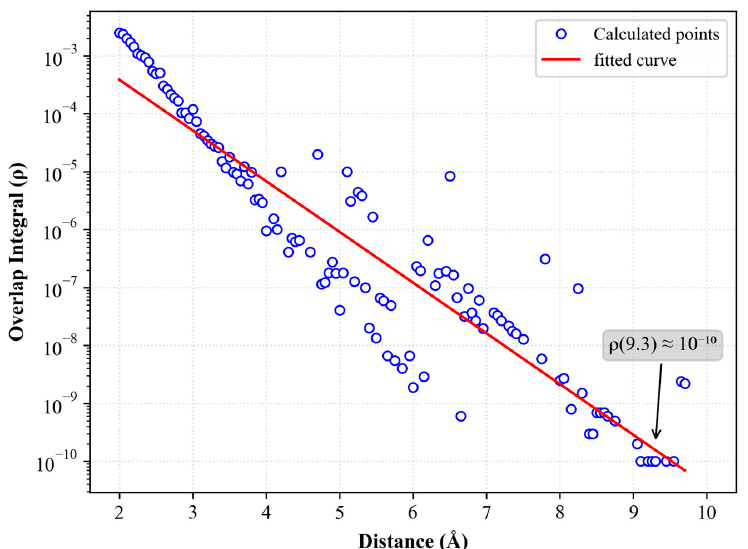
Figure 4. Calculated values and the linear fit of the overlap integral ( ρ ) between the valence orbitals of Cr(III) and Eu(III) ions as a function of the distance between the metal ions, R d − f , obtained with the procedure described in reference [51]. The highlighted point indicates a value of ρ ≈ 10 − 10 when R d − f = 9.3